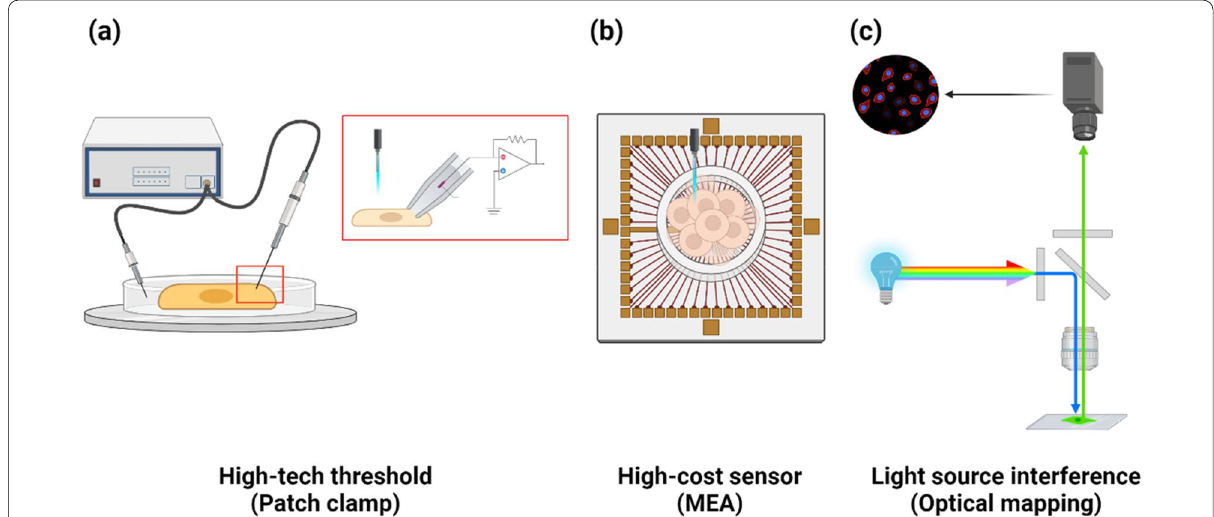
Fig. 6 Optogenetic sensing tool for signal recording. a Patch‑clamp, b microelectrode arrays, c optical mapping. Figure created with BioRender.